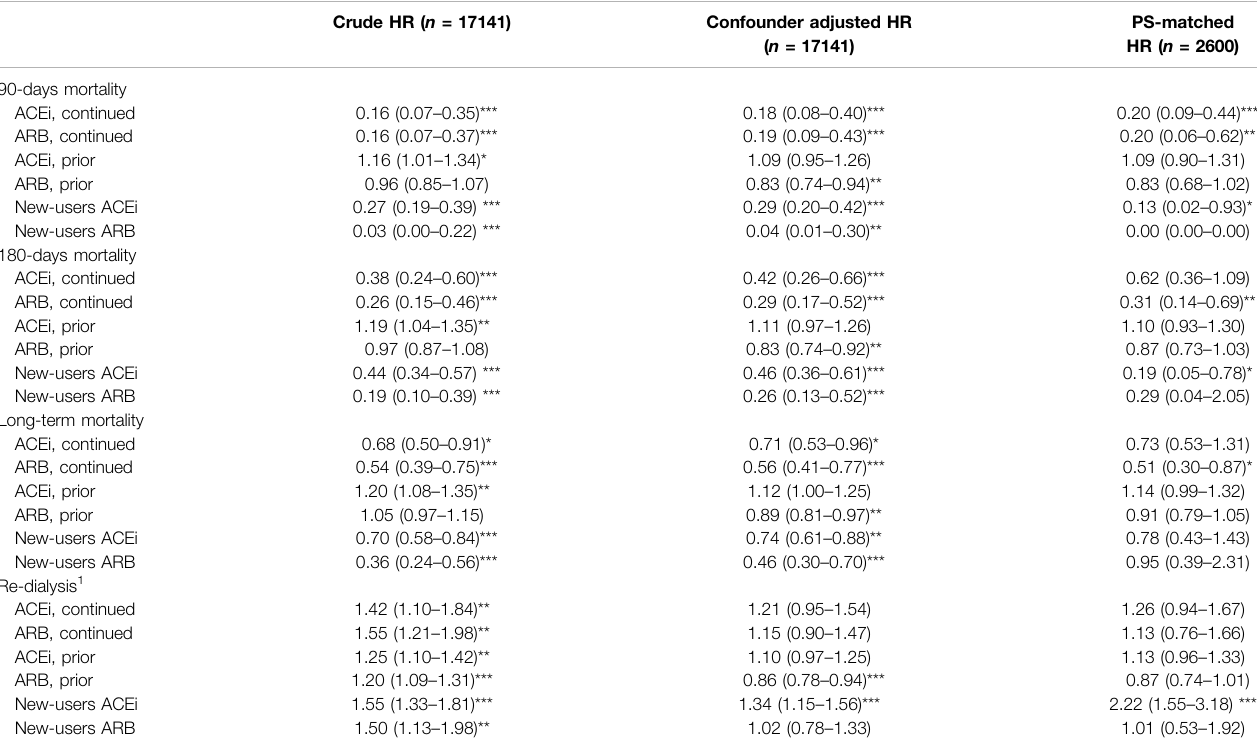
TABLE 3 | Outcomes associated with prior use and continued use of ACEi or ARB in patients weaning from dialysis requiring AKI. Crude HR ( n =